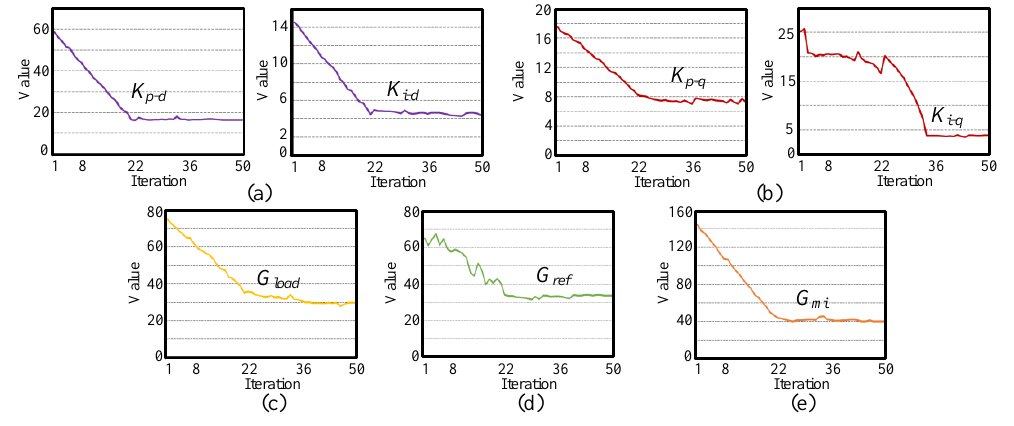
; ( d ) 𝐺 𝐼 ; and 𝑙𝑜𝑎𝑑 𝑟𝑒𝑓 ; ( d ) G I ; and ( e ) G modulation _ index load ref